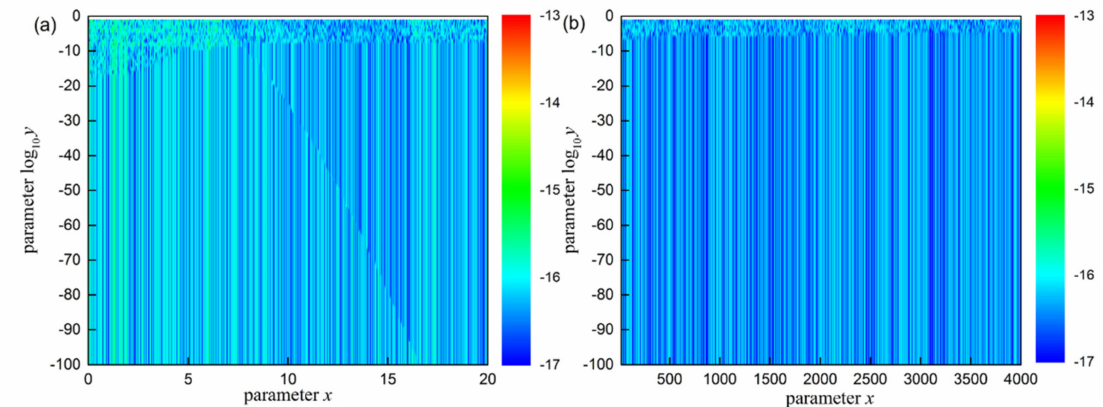
Figure 5. The logarithm of the relative error log 10 ∆ Im for the imaginary part of the evaluation scheme (26) over the domain ( a ) 0 ≤ x ≤ 20 ∩ 10 − 100 ≤ y ≤ 0.1 and ( b ) 20 ≤ x ≤ 40,000 ∩ 10 − 100 ≤ y ≤ 0.1, respectively.